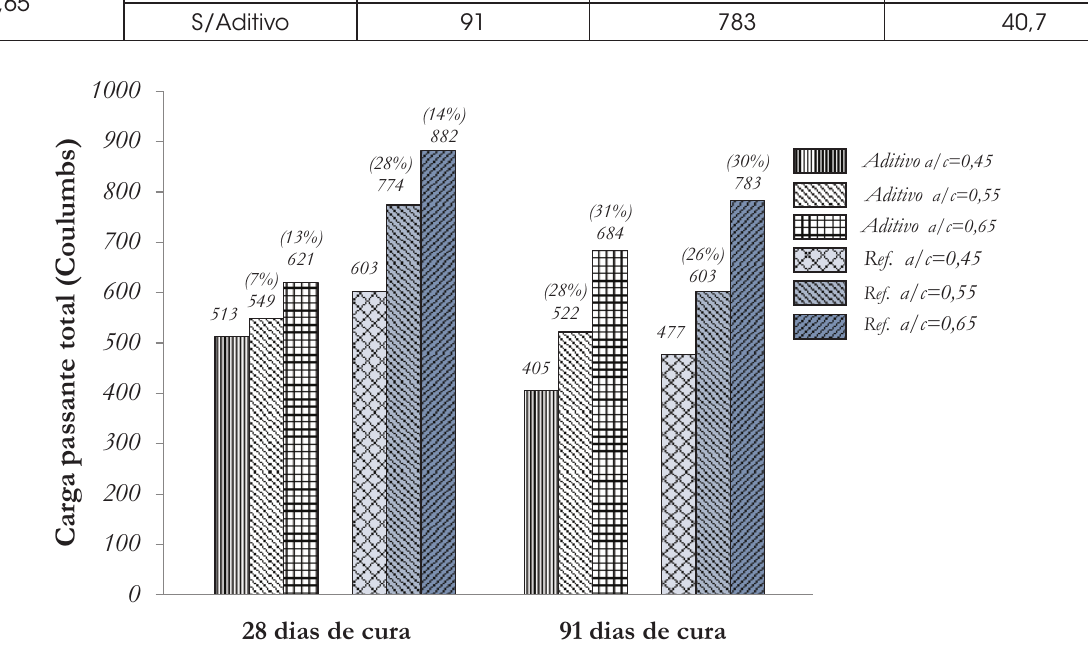
Figura 6 Influência da utilização do aditivo na carga passante